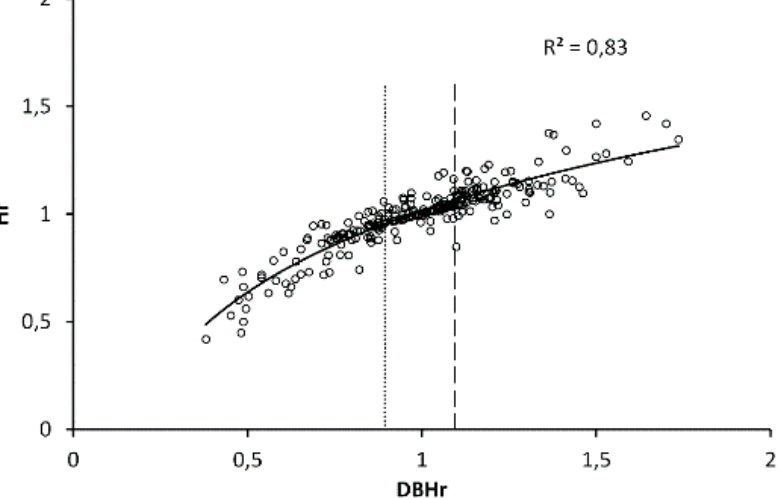
Figure 3. Relative diameter at breast height versus relative height for all analyzed trees. The dotted line indicates the 1/3 percentile and the dashed line the 2/3 percentile of relative diameter, which separates tree size classes (dominant, co-dominant and sub-dominant).